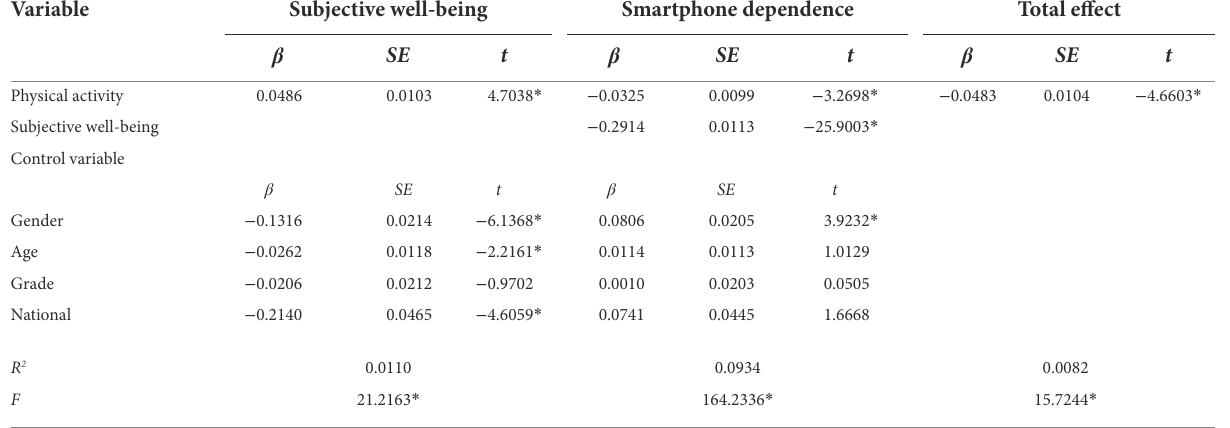
TABLE 4 Mediation effects (standardized).